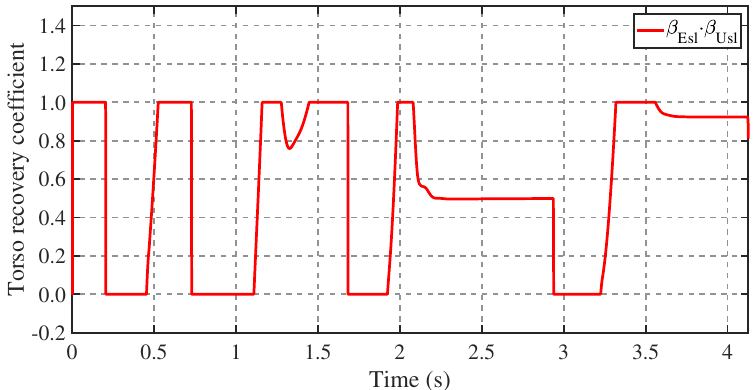
Figure 9. Trajectory of the torso recovery coefficient when the robot slides on uneven terrain.